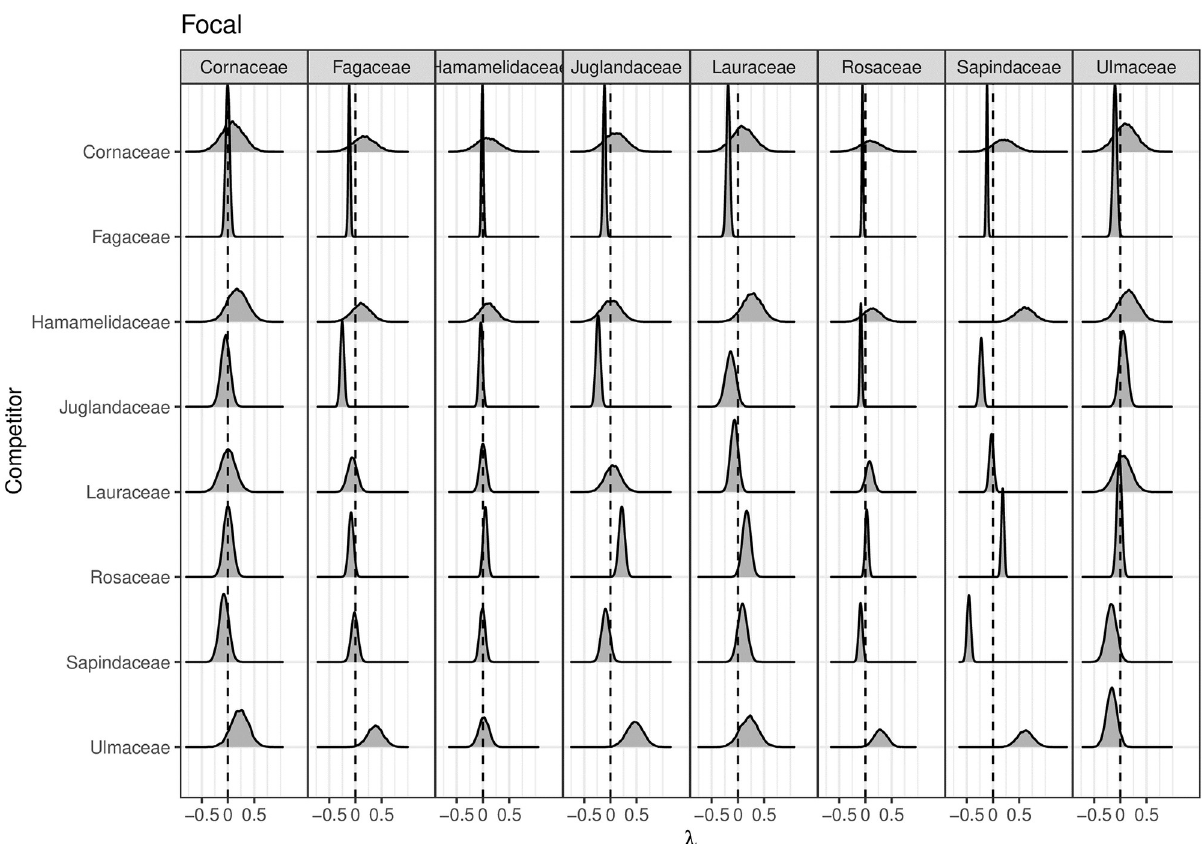
Fig 5. Posterior distribution of λ family-specific competition coefficients. Read across rows for that family’s competitive effect on other families and down columns for that family’s response to competition from other families. Positive values of λ indicate that trees of the focal group tend to grow faster if they have more neighbors of that competitor group, while negative values of λ indicate that trees of the focal group then to grow slower. For example, almost all groups tend to have slower growth in the presence of more Fagaceae neighbors, but tend to have faster growth in the presence of more Ulmaceae neighbors. Here we display just the 8 families for which there are at least 200 individuals in the plot. For a high resolution version of this image for the full 20-by-20 lambda matrix see S1 Fig. A full list of all species and families in the plot can be found in S2 Appendix. See S2 Fig for a phylogeny of these families and S3 Fig for counts of focal and competitor family